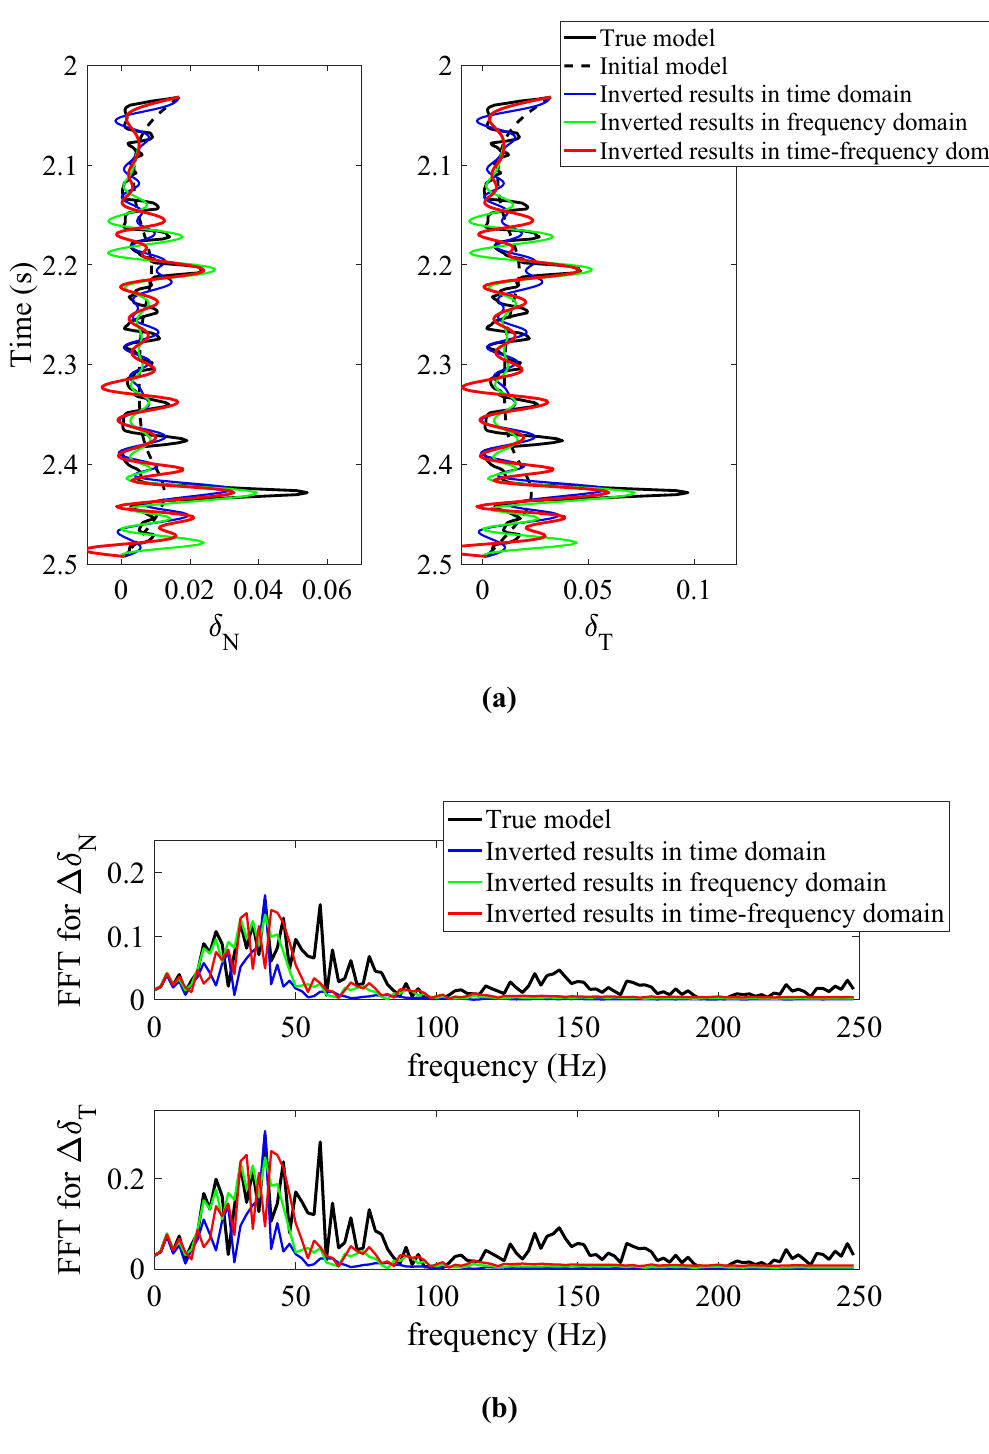
Figure 3. Comparison between original and inverted model parameters and spectra in time domain, frequency domain, and joint time–frequency domain with synthetic azimuth-dependent seismic data containing more noises (SNR = 2), where (a) is the inverted normal and shear fracture weaknesses in different domains, and (b) is the spectra comparison in different